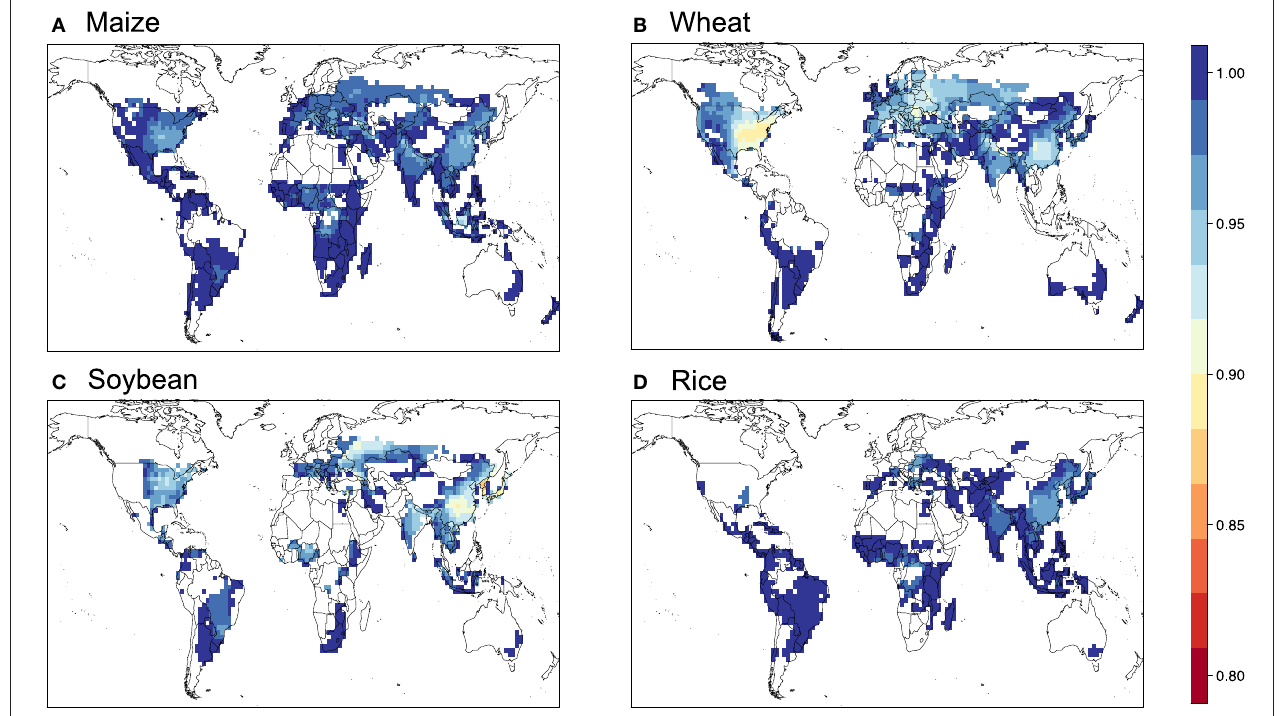
FIGURE 9 | Relative yield based on the flux-based POD 3 metric with FBB formulation for (A) maize, (B) wheat, (C) soybean, and (D) rice.